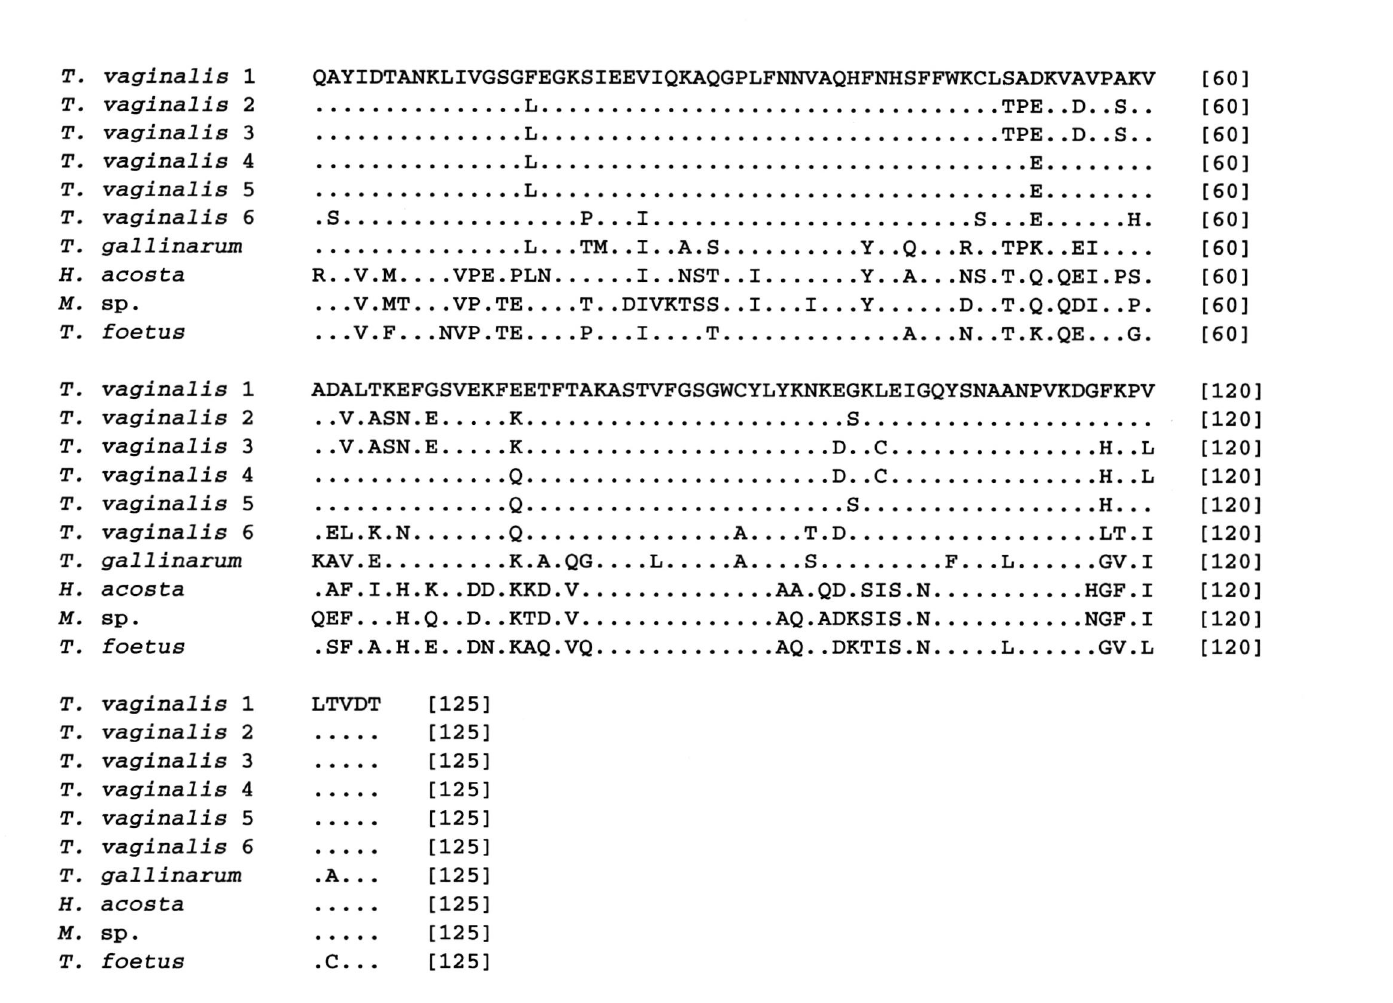
Fig. 1. - Amino acid sequence alignment of partial FeSODl - 6 of Trichomonas vaginalis and partial FeSOD from five reference taxa. This alignment was used for the phylogenetic analyses. T. vaginalis 1 - 6, partial FeSODl - 6 of Trichomonas vaginalis, T gallinarum, FeSOD of Tetratrichomonas foetus, H acosta, FeSOD of Hypotrichomona acosta; M. sp., FeSOD of Monocercomonas sp. Dots indicate amino acids identical with those of the first line (FeSODl of T. vaginalis).